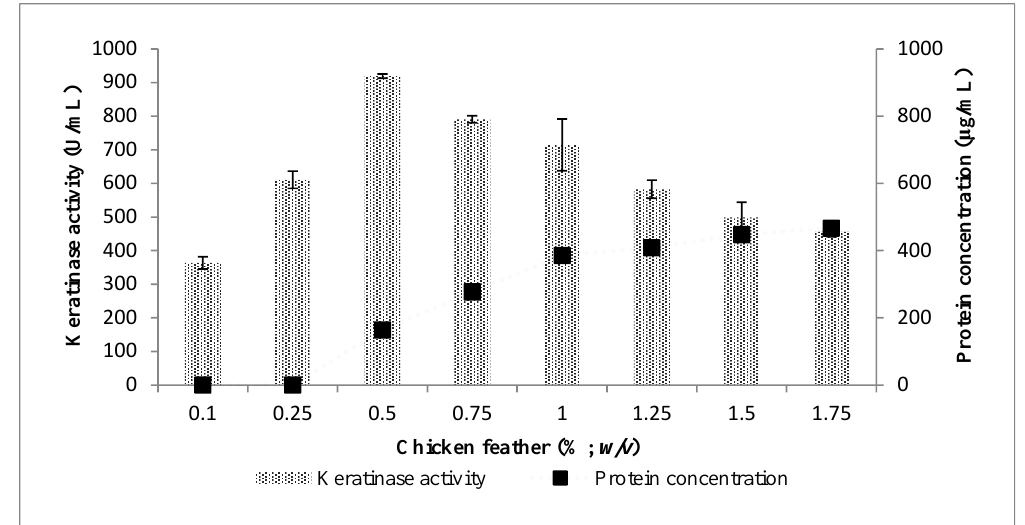
Figure 6. The effect of chicken feather concentration on keratinase activity by Bacillus sp. FPF-1. Figure 6. The e ff ect of chicken feather concentration on keratinase activity by Bacillus sp.